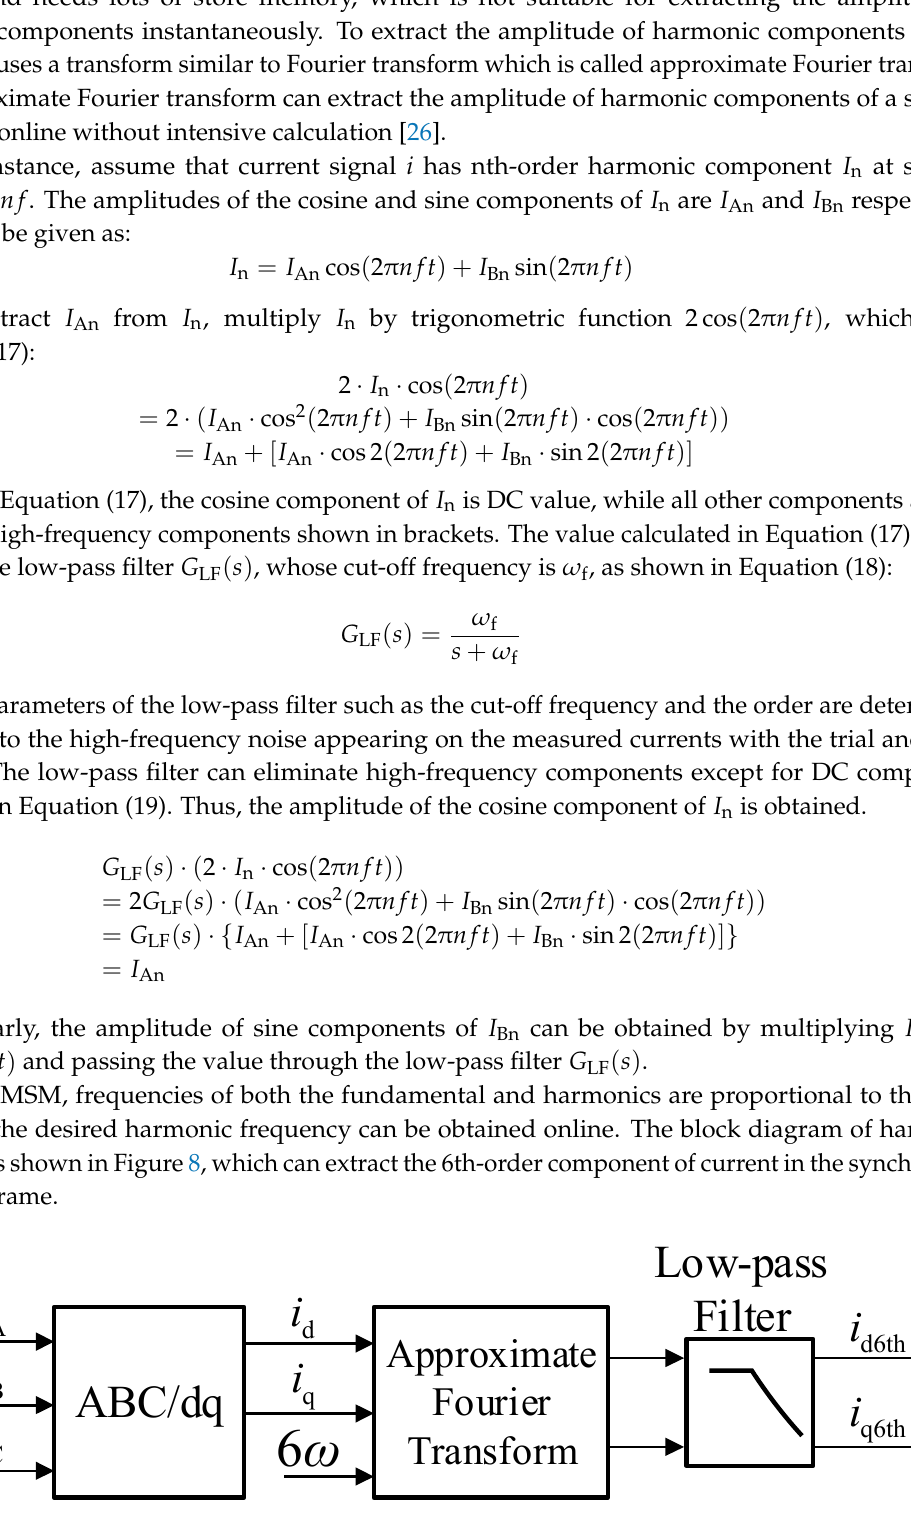
Figure 8. 6th-order harmonic estimator.